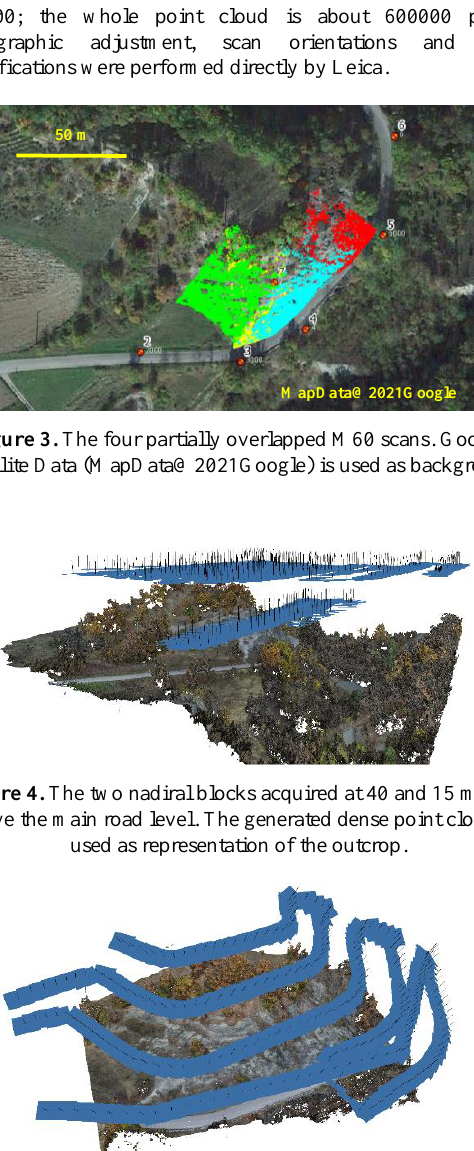
Figure 2. The topographic network whereas the topographic benchmarks are reported with red triangles and GNSS points with light blue squares; green lines represent the topographic Figure 5. The oblique blocks acquired with a 45° tilting observations. Google Satellite Data (MapData@2021Google) is used as background.